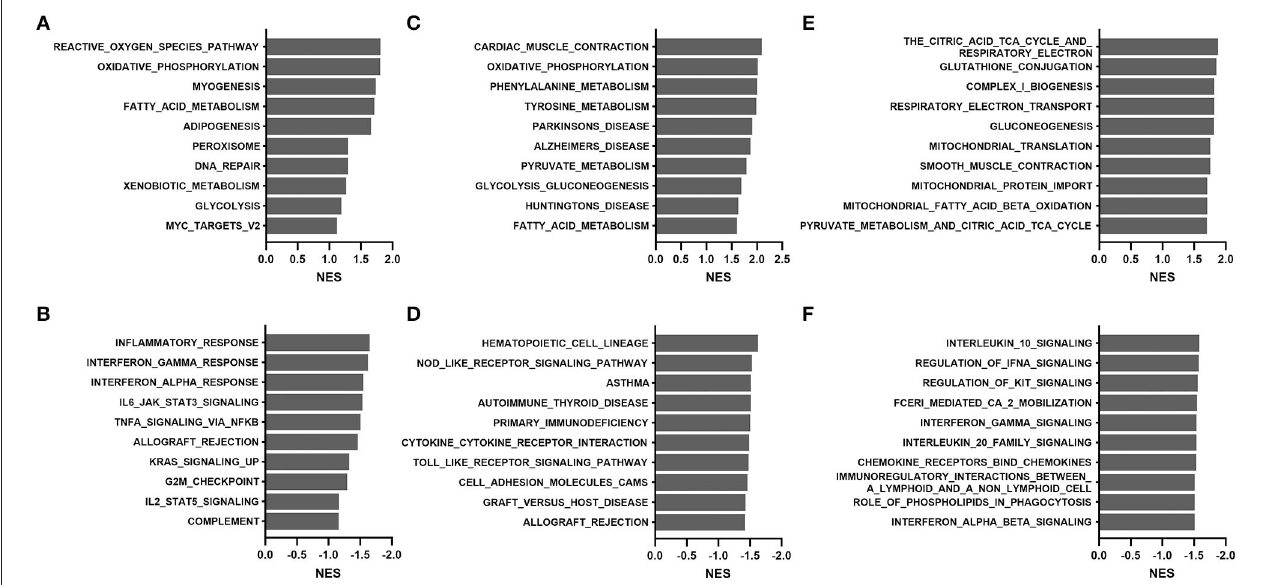
FIGURE 4 | Gene set enrichment analysis of the TCGA THCA dataset comparing the young (15–58 years) and old (60–81 years) groups: (A,B) hallmark, (C,D) KEGG, and (E,F) Reactome. (A,C,E) , positive enrichment; (B,D,F) , negative enrichment. The top 10 hallmarks or pathways are listed. NES, normalized enrichment score.